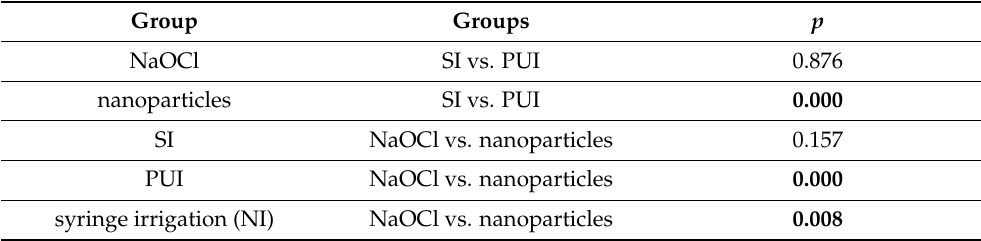
Table 2. Results of the statistical test (level of significance p ≤ 0.05). Significant differences in